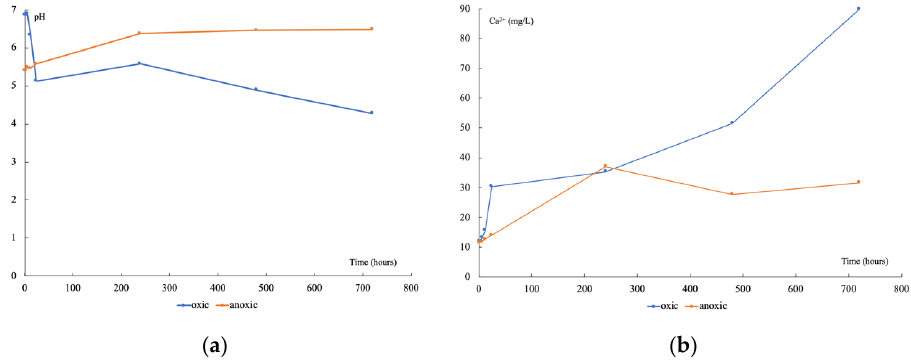
Figure 2. Time variation of pH ( a ), and Ca 2+ ( b ), during the leachate incubations, in oxic (blue) and anoxic (orange) conditions.